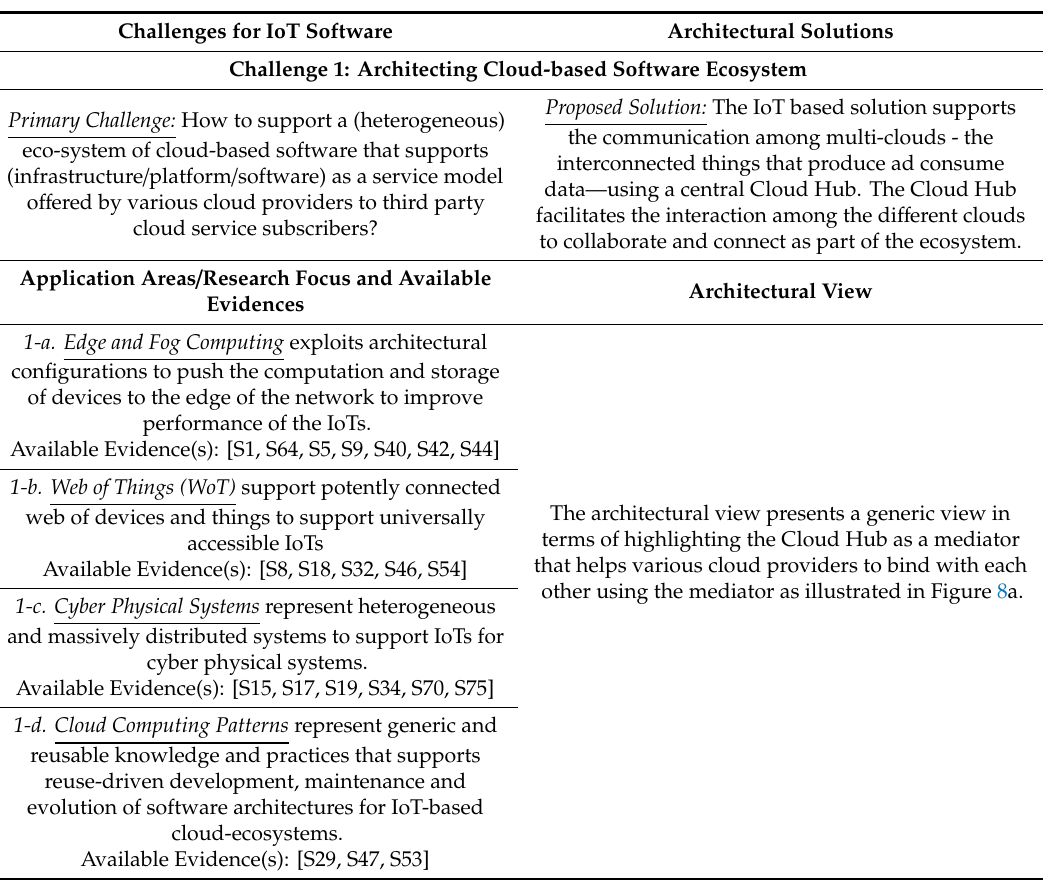
Table 5. Challenge I— Overview of the challenges and architectural solutions for cloud-based software